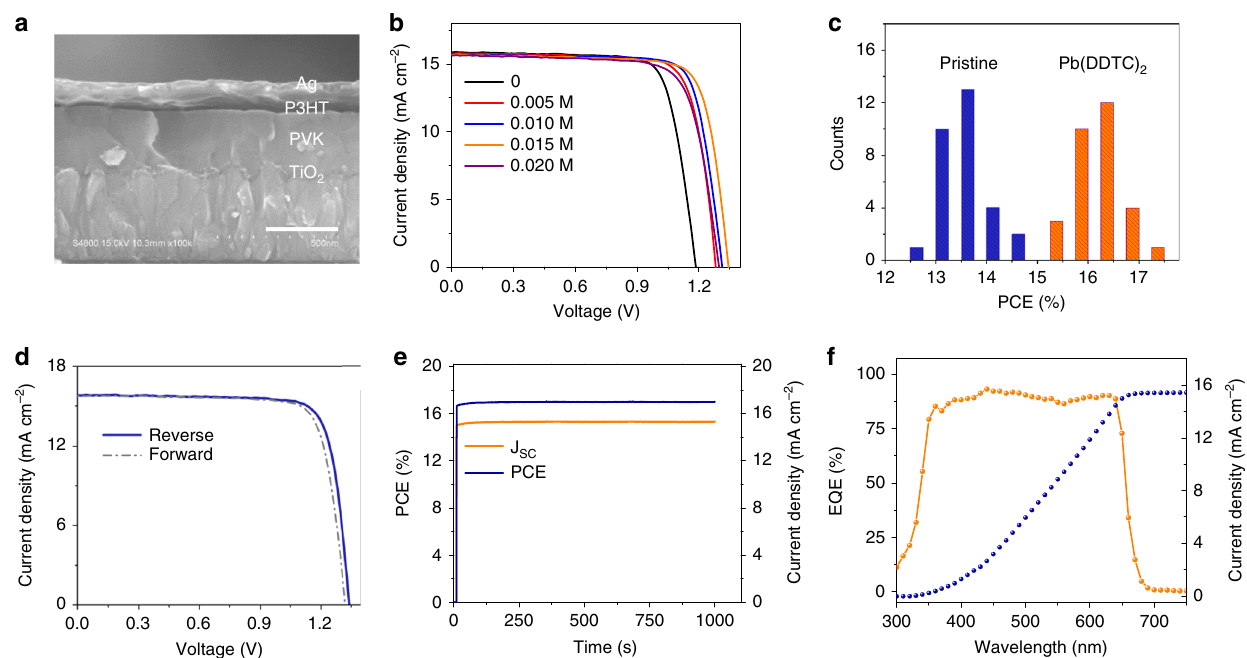
Fig. 2 CsPbI 2 Br PSCs characterizations. a Cross-sectional SEM image of a chelated perovskite device. Scale bar is 300 nm. b J – V curves of perovskite solar cells with different concentrations of Pb(DDTC) 2 under simulated AM 1.5G illumination (100 mW cm − 2 ). c PCE histograms of pristine (blue) and chelated (orange) CsPbI 2 Br PSCs. d J – V characteristics of the champion device for chelated CsPbI 2 Br solar cell at opposite scan directions. e Steady-state power output (blue) and current density (orange) of the champion cell measured at a fi xed maximum power point (MPP) voltage (1.11 V) as a function of time. f EQE spectra (orange) and corresponding integrated photocurrent (blue) of the champion